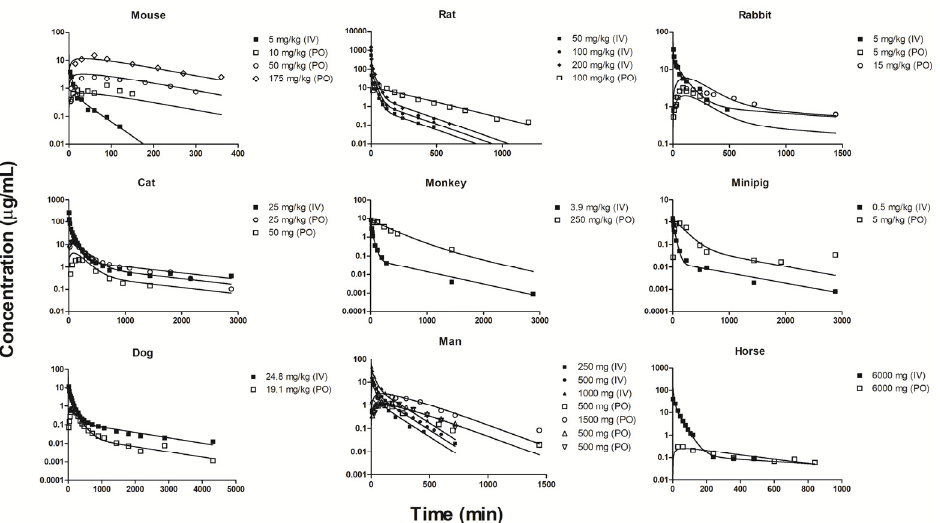
Figure 4. Fitting of intravenous and oral pharmacokinetics of metformin individually for 9 species to the mPBPK model. The slowly-equilibrating compartment (Tissue 2) was assumed to consist of skin and muscle (i.e., 𝑄 (cid:2870) = 𝑄 (cid:3020)(cid:3012) + 𝑄 (cid:3014)(cid:3022) , 𝑉 (cid:2870) = 𝑉 (cid:3020)(cid:3012) + 𝑉 (cid:3014)(cid:3022) ). Fitted parameters are listed in Table 5. Table 4. A priori in silico calculation of the tissue distribution parameters ( 𝐾 (cid:3043) and 𝑓 (cid:3031) ) for 11 typical tissues of rats in the WB-PBPK. The 𝐾 (cid:3043) values were predicted using the Poulin and Theil [81] and Berezhkovskiy [82] methods built in the GastroPlus PBPK simulator, except for the gut. In vitro PAMPA 𝑃 (0.5 × 10 − 6 cm/s) and fitted 𝑃 (0.0102 × 10 − 6 cm/s) were used to calculate the mean transit time ( 𝑀𝑇𝑇 ).